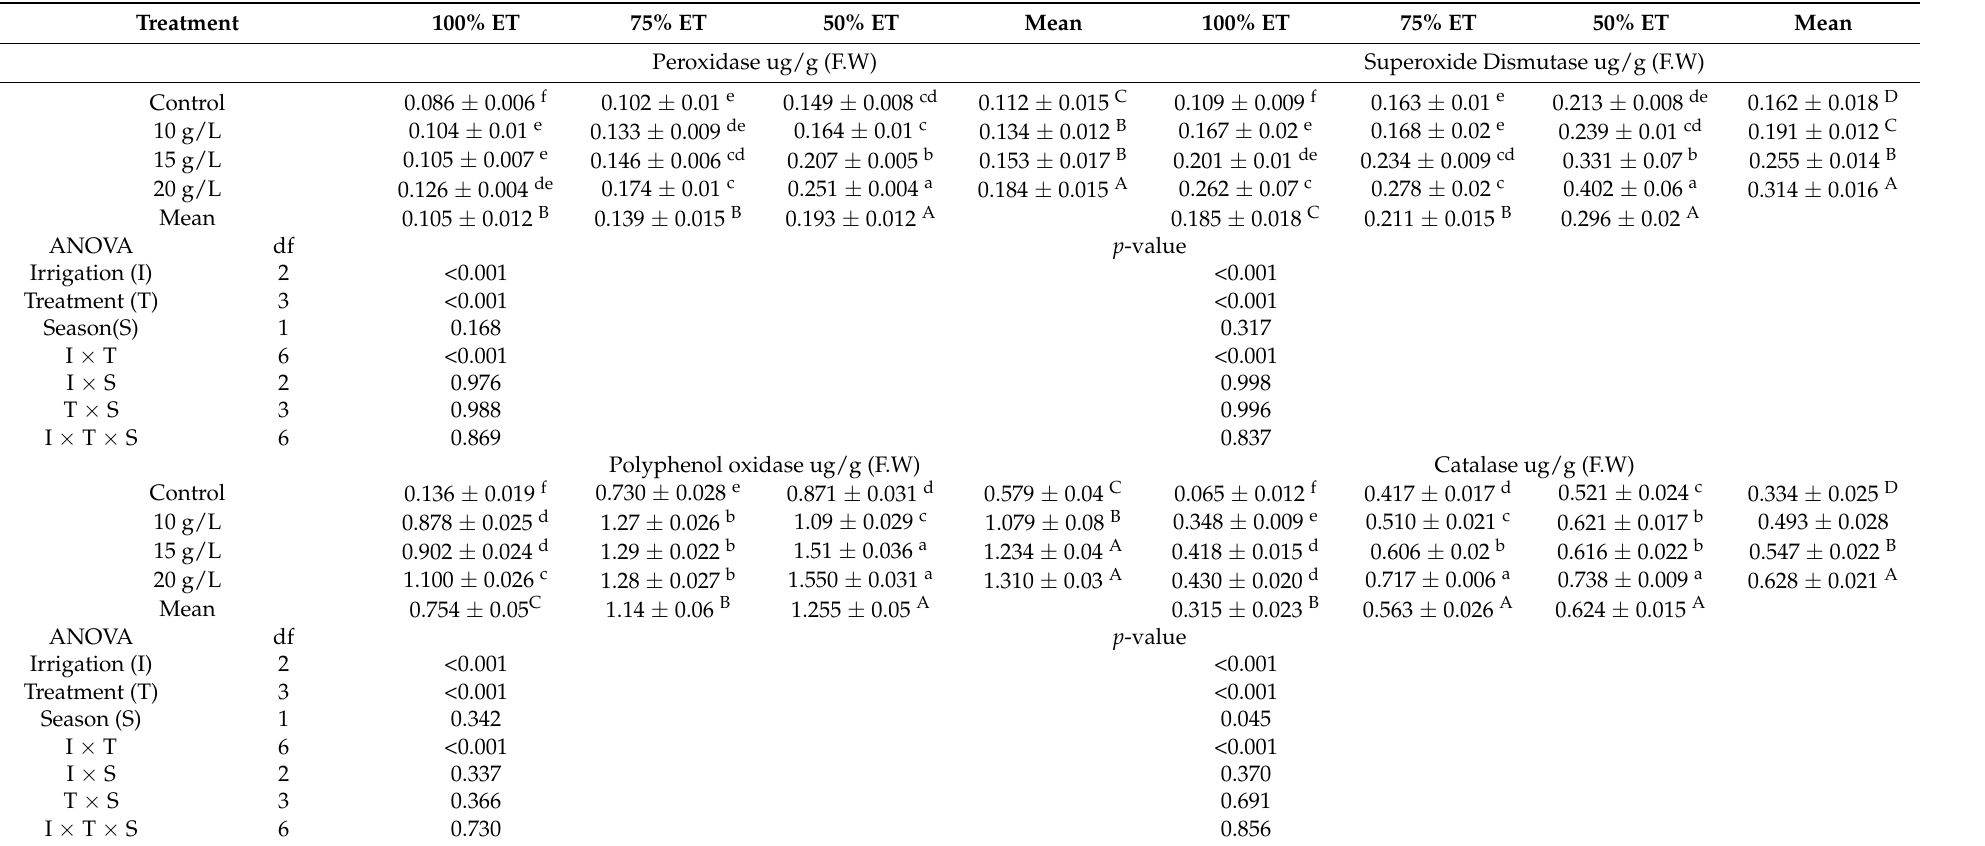
Table 1. Influence of potassium silicate on the activity of peroxidase (POD), superoxidase dismutase (SOD), polyphenol oxidase (PPO), and catalase (CAT) of squash plants under different irrigation